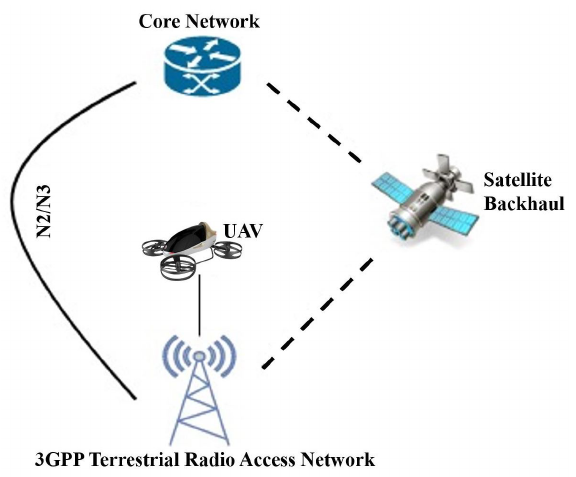
Figure 3. 5G System with a satellite